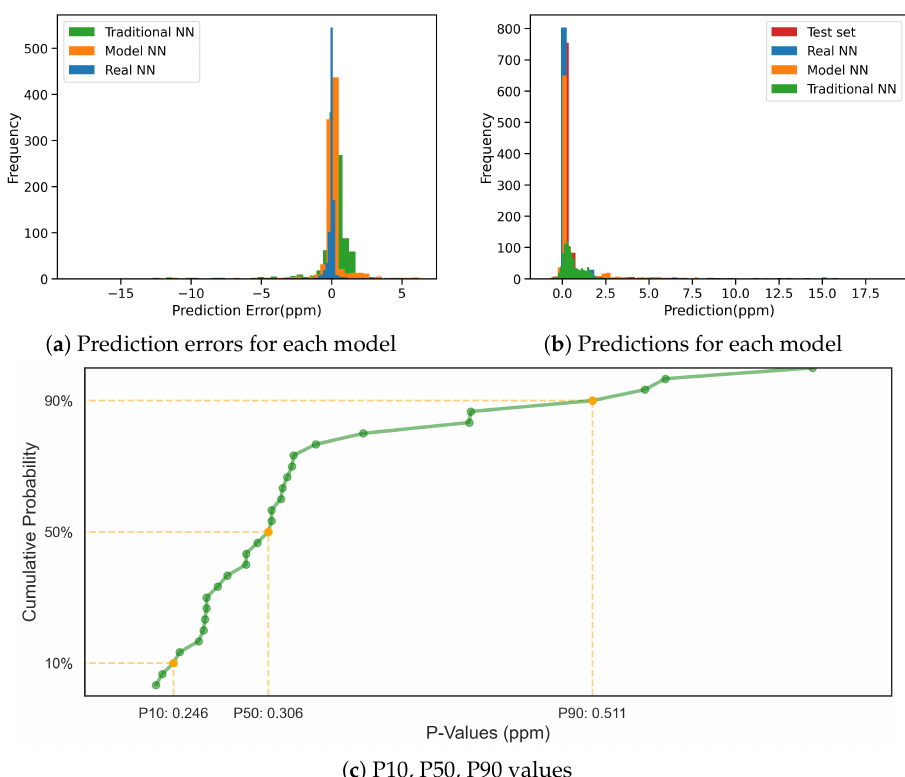
Figure 9. Simulation 23, histogram of prediction performances and p -values.